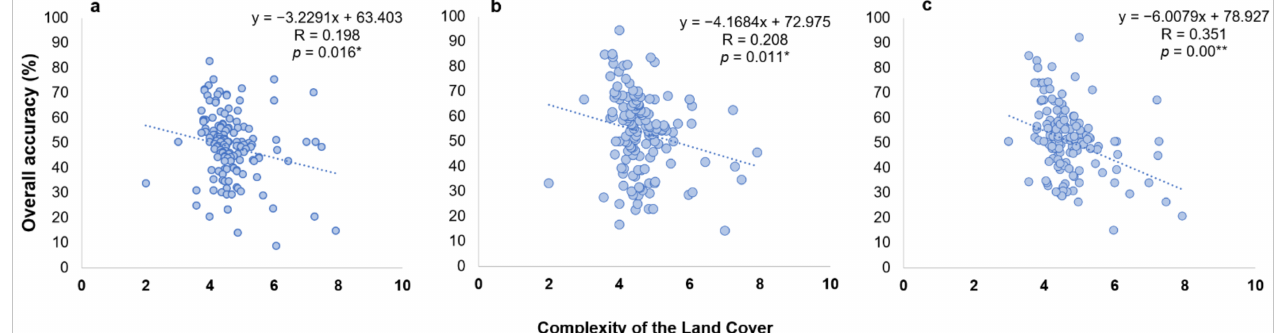
Figure 13. Correlation between the weighted complexity of land cover types and overall accuracy in epoch 2020: ( a ) CCI-LC ( b ); CGLS-LC; ( c ) GlobeLand30. The asterisks * and ** denote the significance level of 95% and 99%,